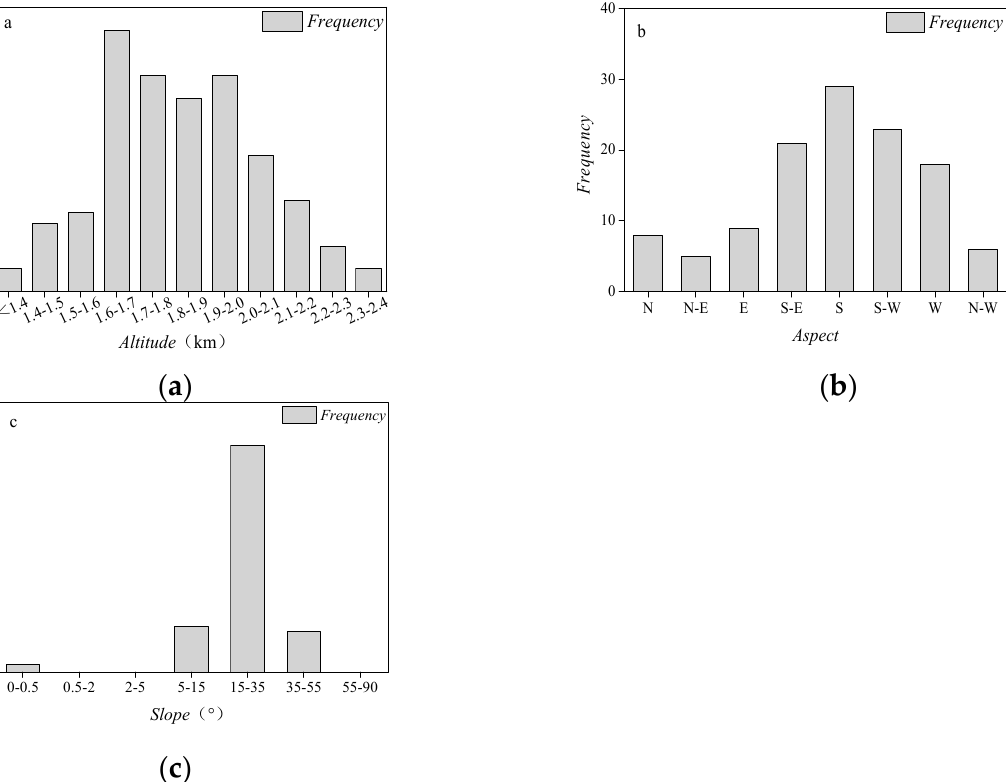
Table 6. Incidence (%) of D. armandi in China.